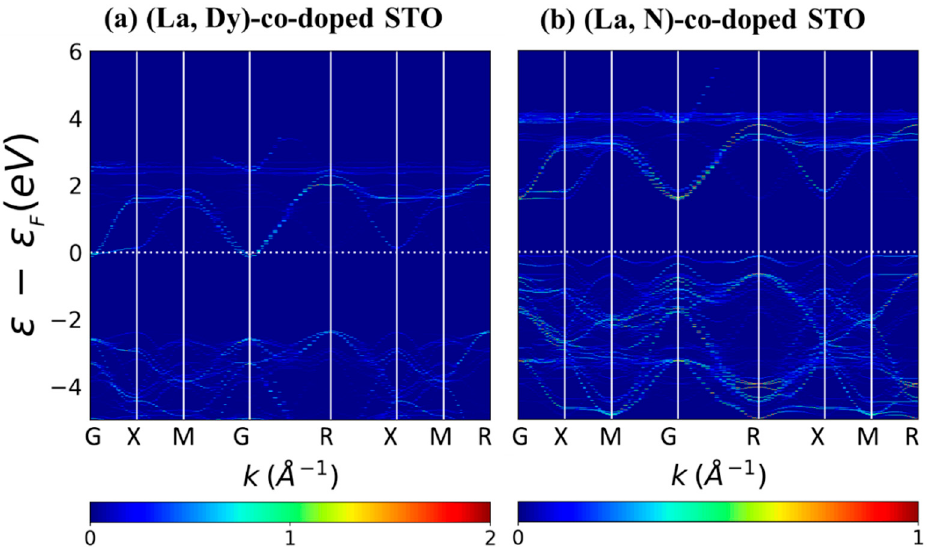
Figure 6. Band structure of (La, N)-co-doped SrTiO 3 . White dashed lines represent the Fermi level, set to zero, and the DOS scale is shown at the bottom of the figure.